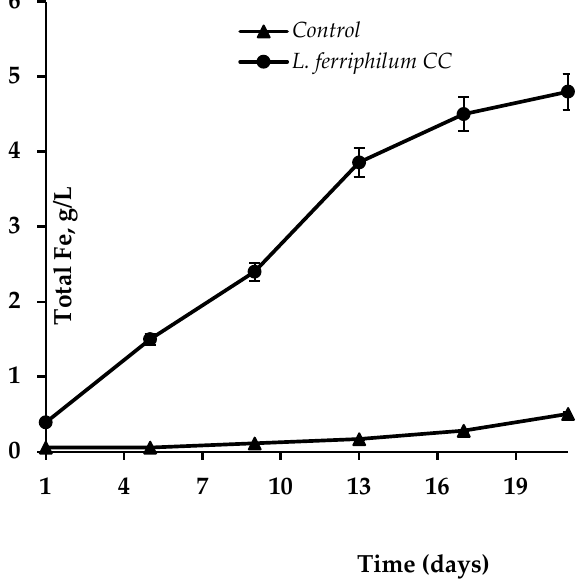
Figure 4. Bioleaching of pyrite by L. ferriphilum CC (T 40 °C; pH 1,5; PD 4%).